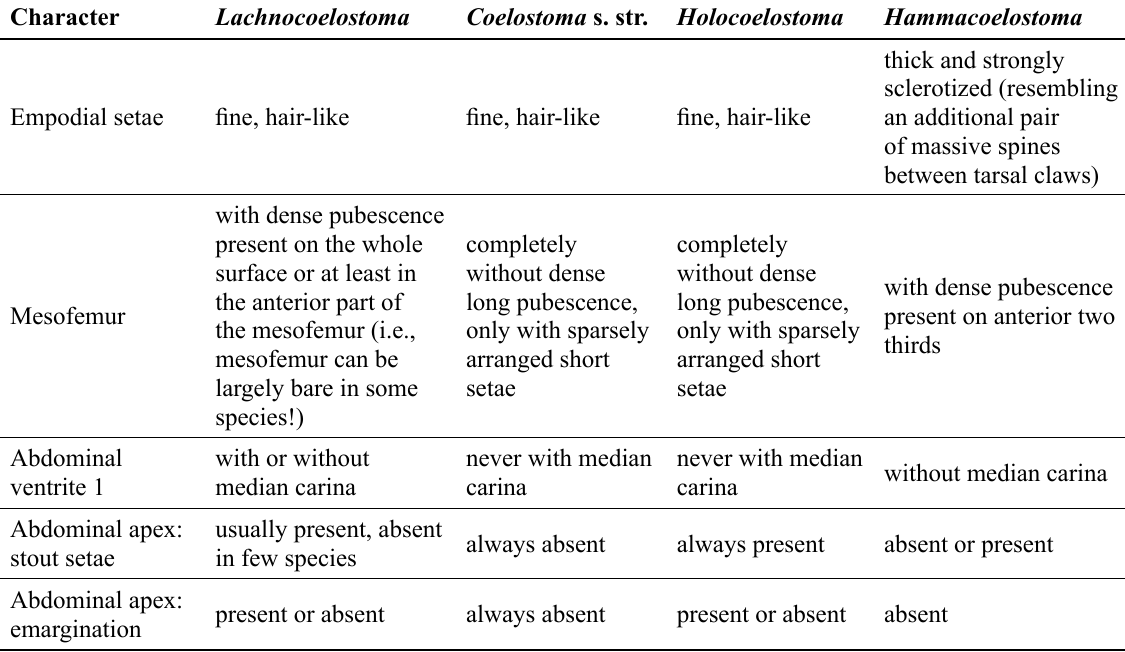
Table 1. Characters defining the subgenera of Coelostoma Brullé, 1935 as used in this study. Only the subgenera Lachnocoelostoma Mouchamps, 1958, Coelostoma s. str. and Holocoelostoma Mouchamps, 1958 occur in the Indian